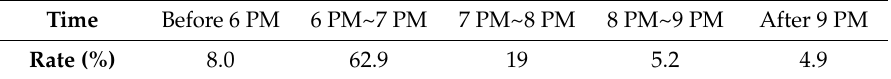
Table 16. Data regarding the time when o ffi ce workers leave the o ffi ce in South Korea.